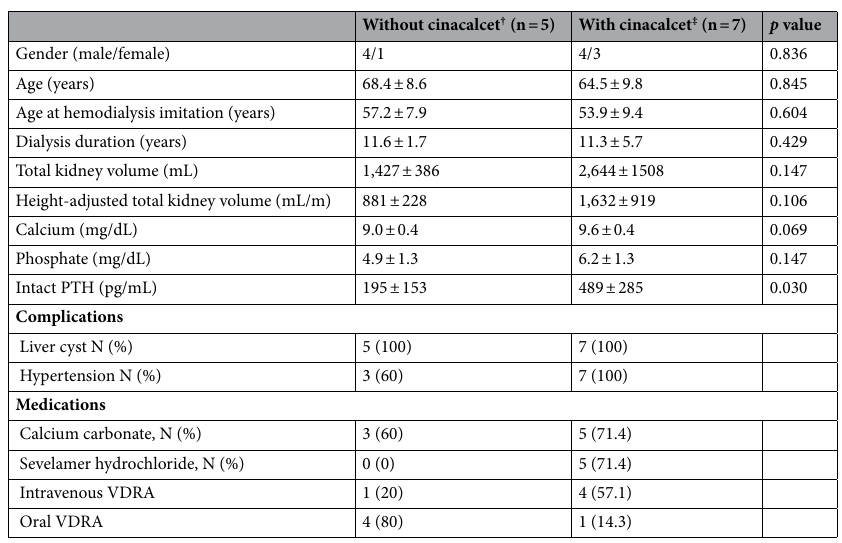
Table 1. Baseline clinical characteristics of enrolled hemodialysis patients with autosomal dominant polycystic kidney disease (n = 12). Values are expressed as mean ± SD. Unpaired Student’s t-test was used for comparisons of continuous variables that exhibited a normal distribution. Mann–Whitney U test was used for comparisons of continuous variables with skewed distribution. Chi-squared test was used for comparisons of categorical variables. PTH parathyroid hormone, VDRA vitamin D receptor activators. † Obtained at the time of computed tomography examination. ‡ Before starting cinacalcet treatment.